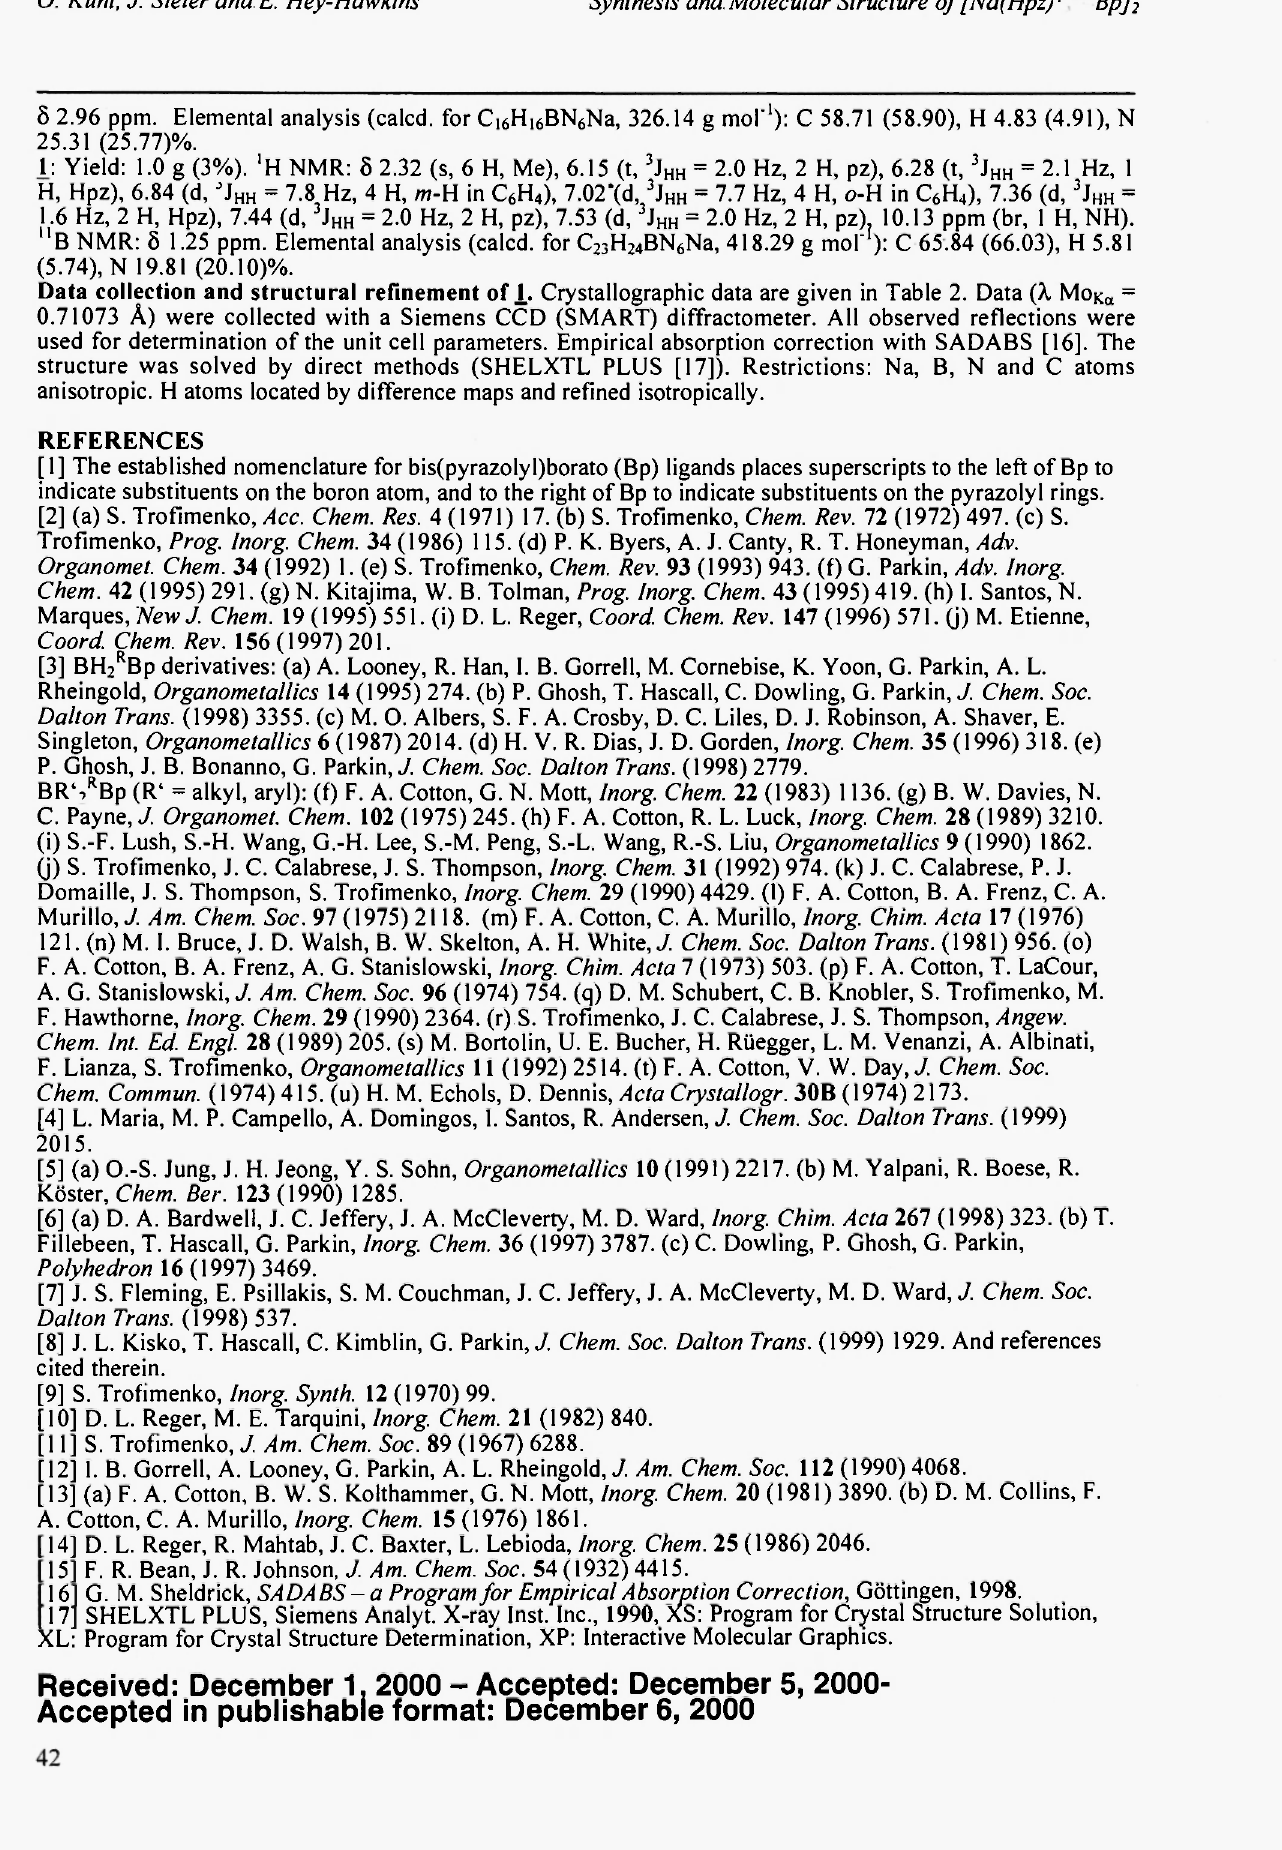
Data collection and structural refinement of χ. Crystallographic data are given in Table 2. Data (λ Μο Κα = 0.71073 A) were collected with a Siemens CCD (SMART) diffractometer. All observed reflections were used for determination of the unit cell parameters. Empirical absorption correction with SADABS [16]. The structure was solved by direct methods (SHELXTL PLUS [17]). Restrictions: Na, Β, Ν and C atoms anisotropic. Η atoms located by difference maps and refined